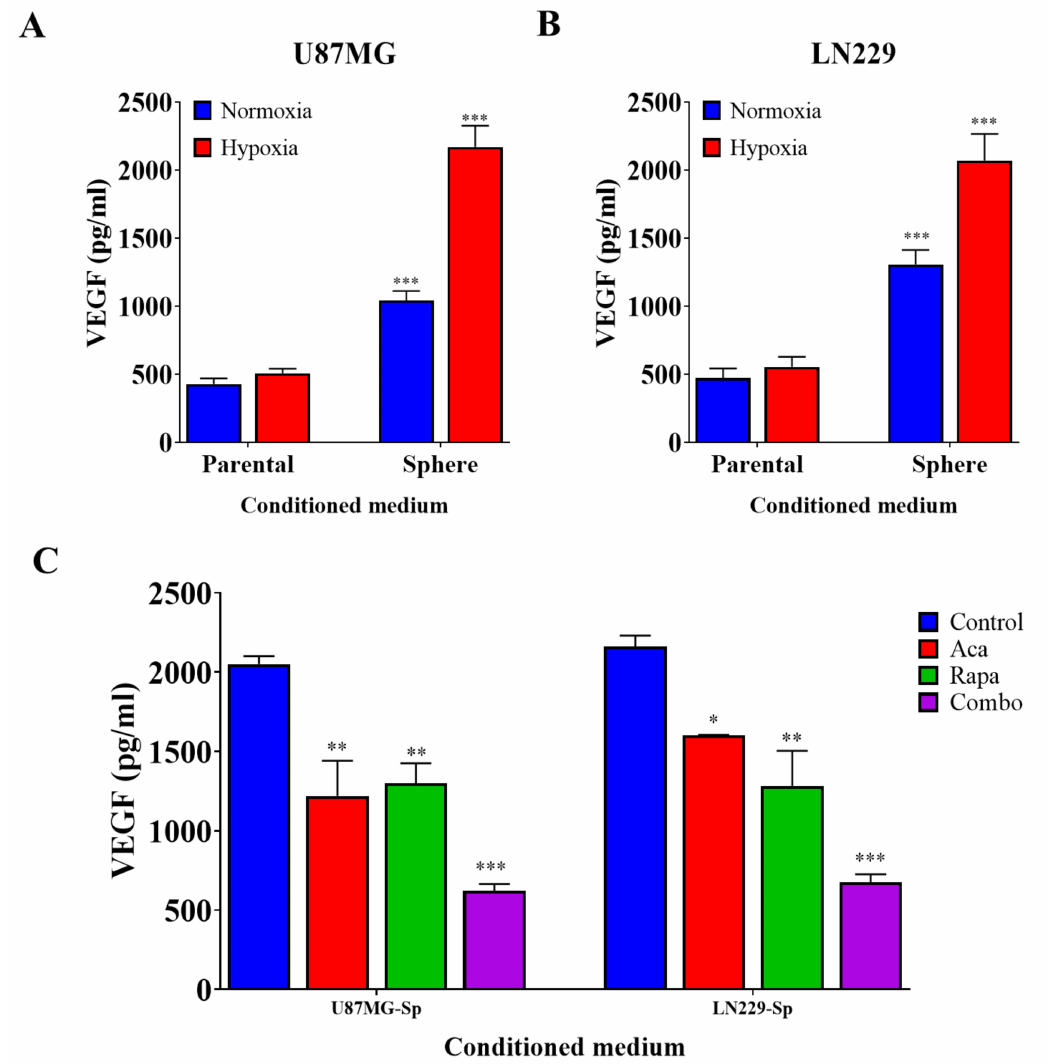
Figure 3. Evaluation of VEGF secretion in parental- and sphere-conditioned media through ELISA. A higher expression of VEGF was observed in the sphere-conditioned medium than in the parental-conditioned medium during hypoxia in ( A ) U87MG and ( B ) LN229 GBM cell lines. ( C ) Combination therapy with acalabrutinib and rapamycin markedly diminished VEGF expression in U87MG-sp and LN229-sp conditioned media. * p < 0.05; ** p < 0.01; *** p <